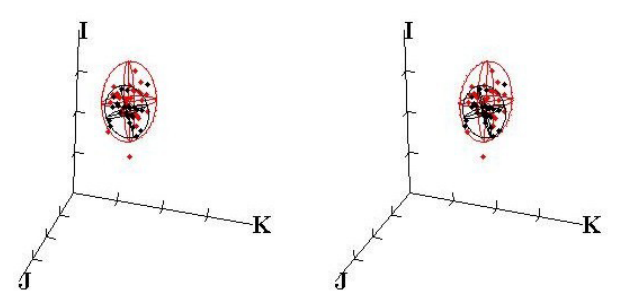
Figure 7 . 95% confidence ellipsoids for the first subject in the PMMA group. P1 is represented by the black ellipsoid and P2 is represented by the red ellipsoid. Data points were not included to enhance visibility of the confidence ellipsoids. The origin is